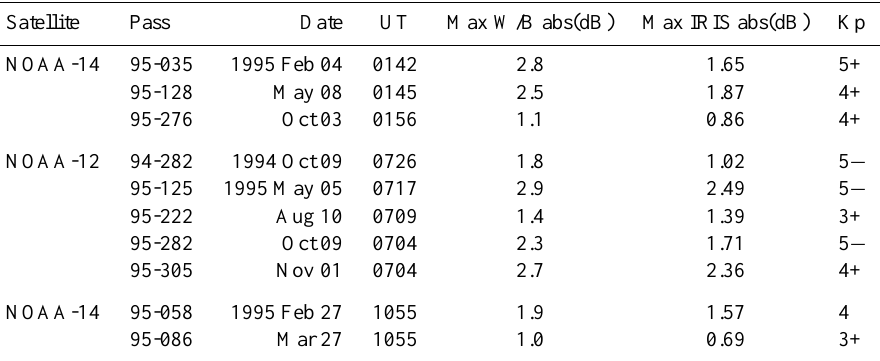
Fig. 5. Absorption distributions over a 240km square, centred on Kilpisj¨arvi, at 30-s resolution, for the times of two overpasses: (a) 5 May 1995 from 07:14:30 to 07:19:00UT; and (b) 4 February 1995 from 01:39:30 to 01:44:00UT. Each panel covers the same area as Fig. 3. Table 2. Overpasses of Kilpisj¨arvi during significant radio absorption (passes on 13 March and 9 October 1995 having been removed because of possible proton